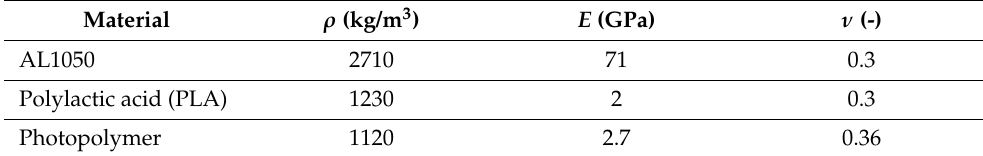
Table 1. Typical mechanical and physical properties of materials that are used in this